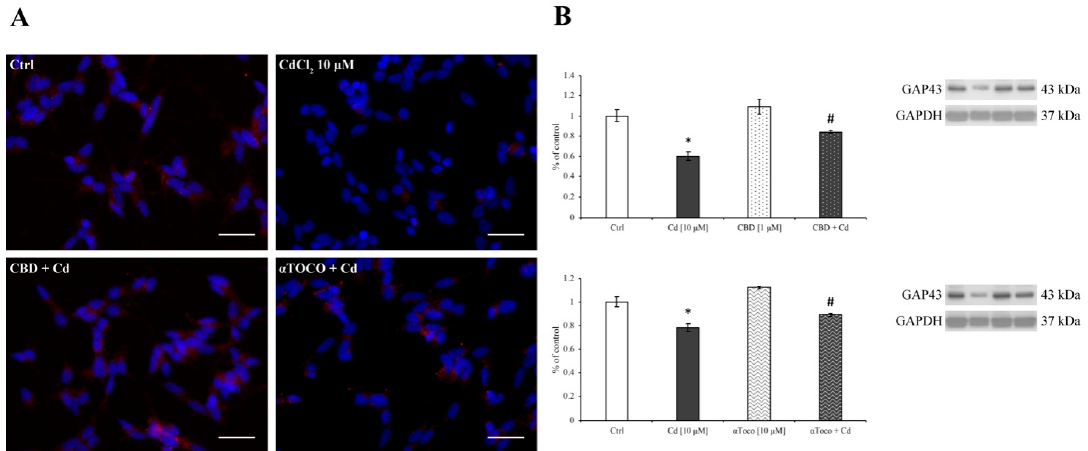
Figure 6. GAP43 expression on SH-SY5Y . ( A ) Immunofluorescent images of GAP43. As shown, a significant decrease was observed after CdCl 2 treatment. Differently, when SH-SY5Y were pre-treated with CDB or α Toco, the GAP43 levels were superimposable on control, untreated cells. ( B ) GAP43 expression levels evaluated by western blotting analysis. As expected, CdCl 2 (dark columns) treatment significantly decreased the protein expression after 24 h treatment. On the other hand, CBD (dotted dark column) or α Toco (wavy dark column) were able to preserve the Cd-dependent GAP43 down-regulation expression levels. Results are expressed as mean ± S.E.M. Control, untreated cells, were taken as 100%. The housekeeping GAPDH protein was used as an internal control for protein normalization. Each experiment point was performed in triplicate, from three different set of experiments. Total magnification: 400×. Scale bar: 25 μ m. * p < 0.05 vs. Ctrl; # p < 0.05 vs. Cd.